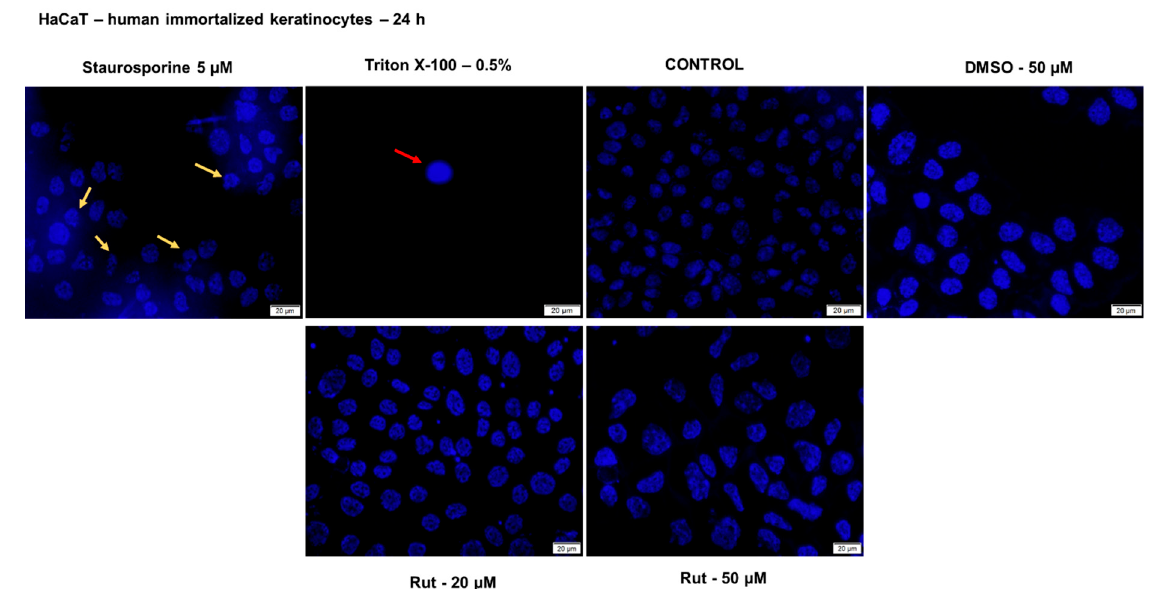
Figure 10. Cell nuclei staining using Hoechst 33342 in HaCaT cells after treatment with Rut (20 and 50 µ M) and DMSO for 24 h. The pictures were taken 24 h posttreatment. Staurosporine solution (5 µ M) represents the positive control for apoptotic changes at the nuclear level and Triton X-100 solution (0.5%) for necrosis. The yellow arrows indicate apoptotic cells with nuclear fragmentation, and the red arrow indicates a necrotic cell. The scale bars represent 20 µm.